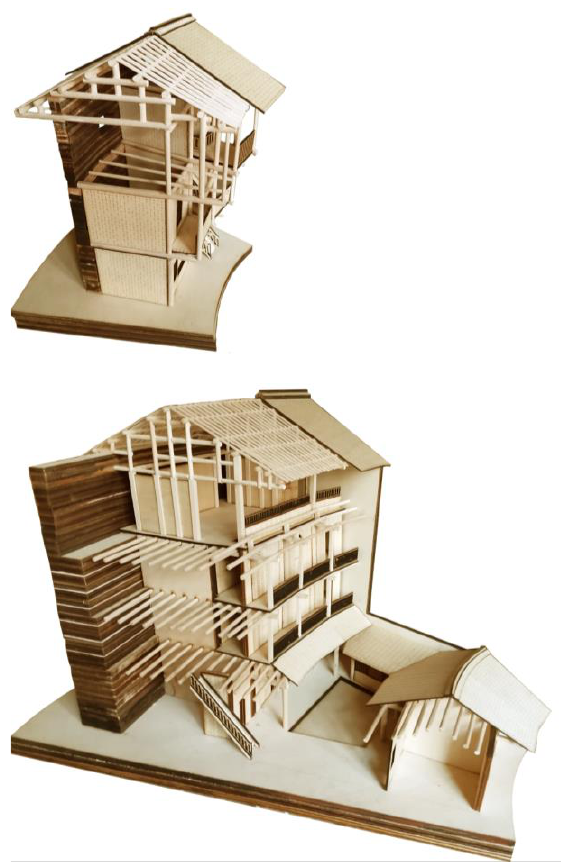
Figure 6. Study scale model: above, case study He Xing Lou, 1943, Yongding County (Hakka Tulou, gallery type); below, case study Er Yi Lou, 1740, Dadi settlement, Hua’an